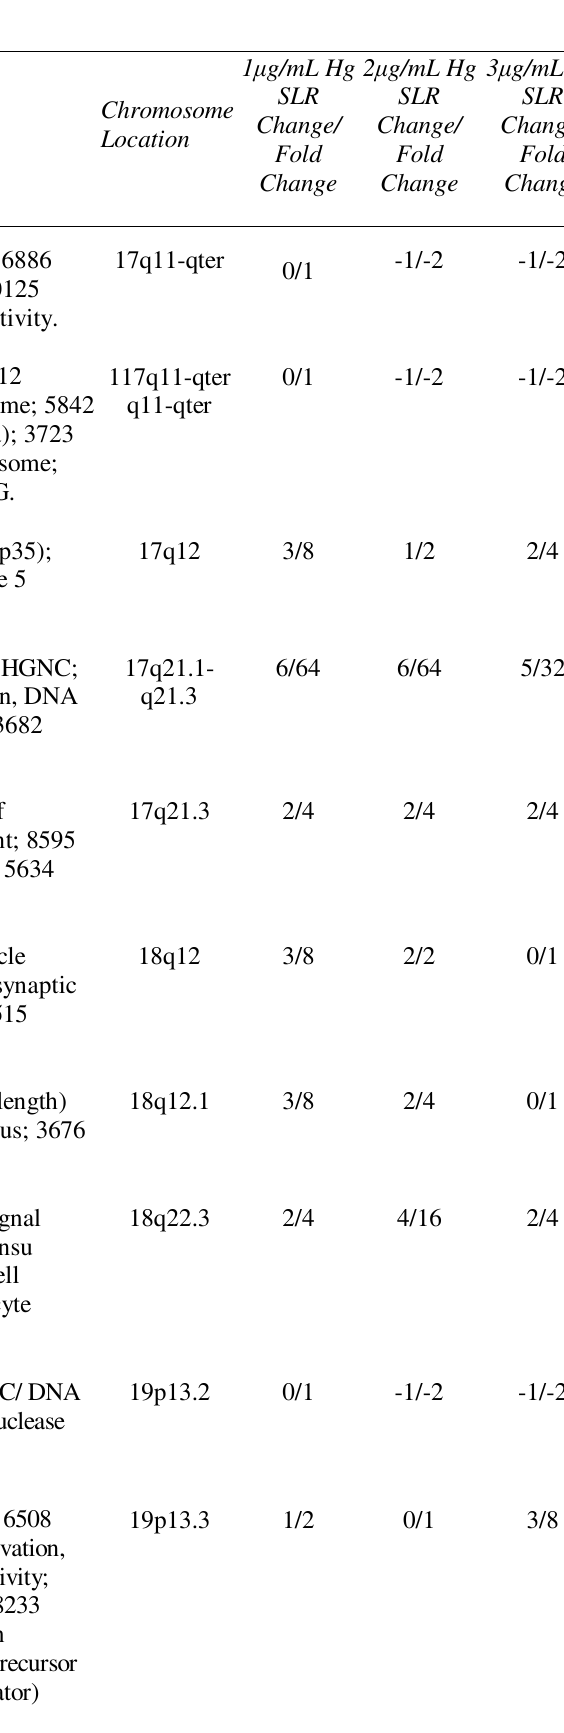
Table 1 contd.: Sample genes affected by mercury. Probe Set